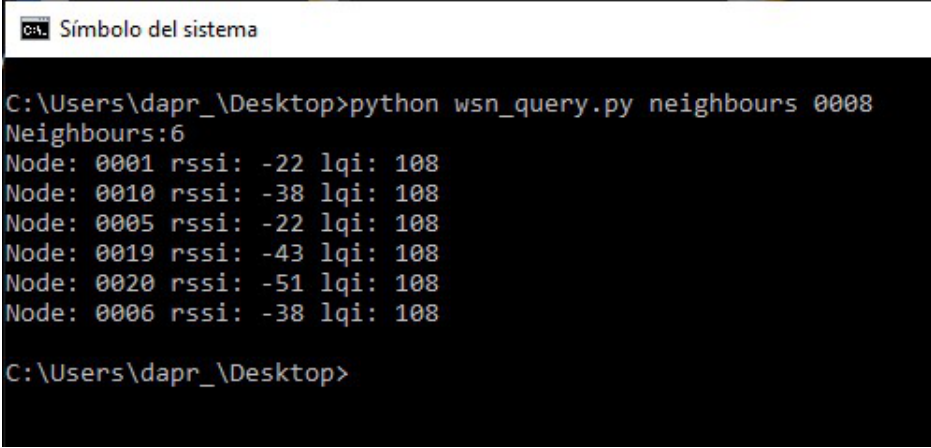
Figure 2. Routing node network neighbor